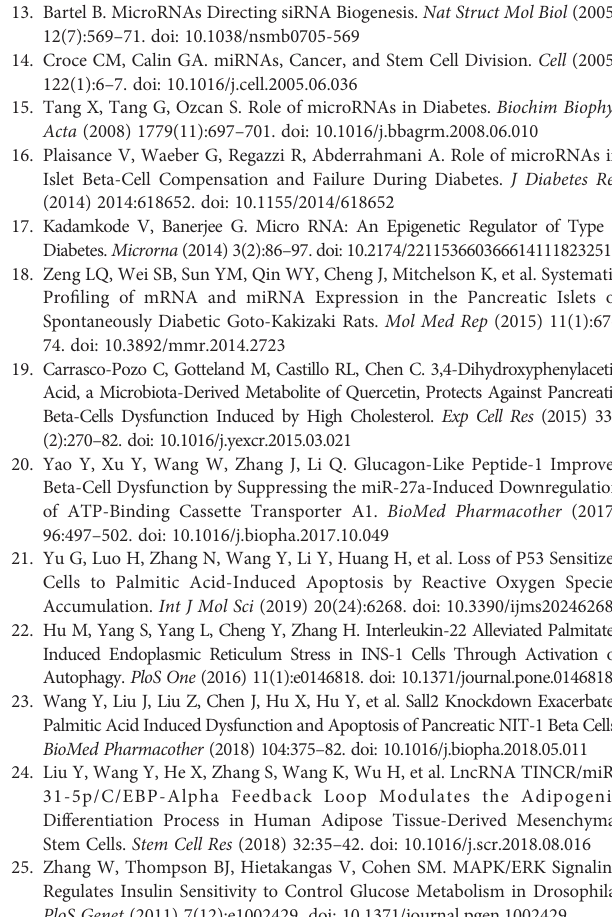
Supplementary Figure 1 | Selection of miRNAs related to diabetes b -cell dysfunction. (A) Volcano plots of abnormally upregulated and downregulated miRNAs in dorsal root ganglia tissues between diabetic and normal rats based on GSE110234. Green plots represent downregulated miRNAs, and red plots represent upregulated miRNAs. (B) Hierarchical clustering heatmap showing the differentially expressed 14 miRNAs in dorsal root ganglia tissues between diabetic and normal rats based on GSE110234. Supplementary Figure 2 | The role of palmitic acid (PA) on INS-1 cells ’ lipotoxicity and the function of miR-344 regulates PA-induced lipotoxicity. (A) INS-1 cells were treated with 0.5 mM PA for 24 h and examined for cell viability by MTT assay. (B) The cell apoptosis was examined by Flow cytometry assay. (C) The protein levels of Bcl-2, Bax, and cleaved-caspase 3 were detected by immunoblotting, and b -actin was applied as an endogenous control. (D) The expression level of miR-344-5p was determined by real-time PCR. (E) INS-1 cell was transfected with miR-344-5p mimic or inhibitor for 48 h, treated with 0.5 mM PA for 24 h, and examined for cell viability by MTT assay. (F) The intracellular cholesterol levels were detected by cholesterol assay kits. (G) The glucose- stimulated insulin secretion (GSIS) was measured by an insulin ELISA kit. * P < 0.05, ** P < 0.01 compared to Control